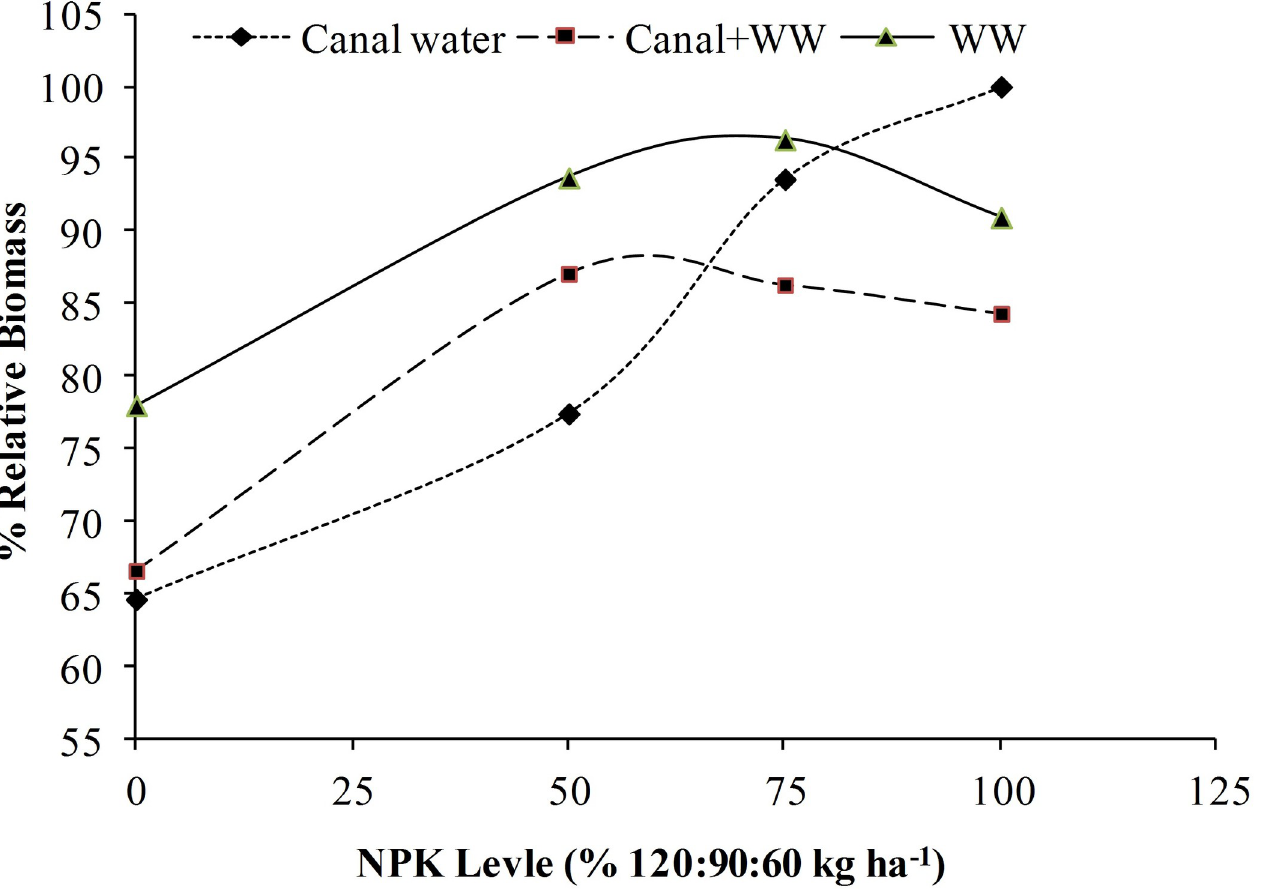
Fig 3. Per cent relative biomass of wheat as influenced by different NPK levels and irrigation